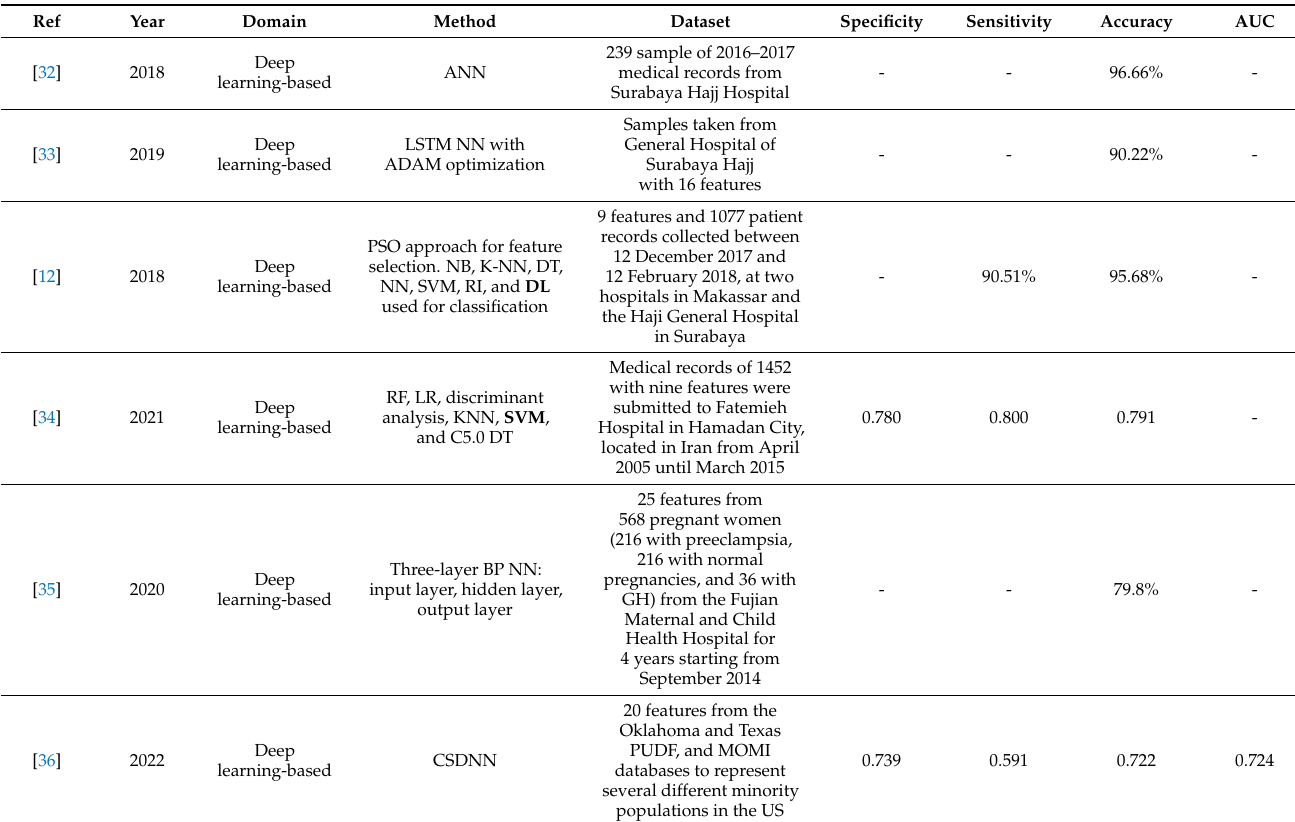
Table 3. Summary of related studies using deep